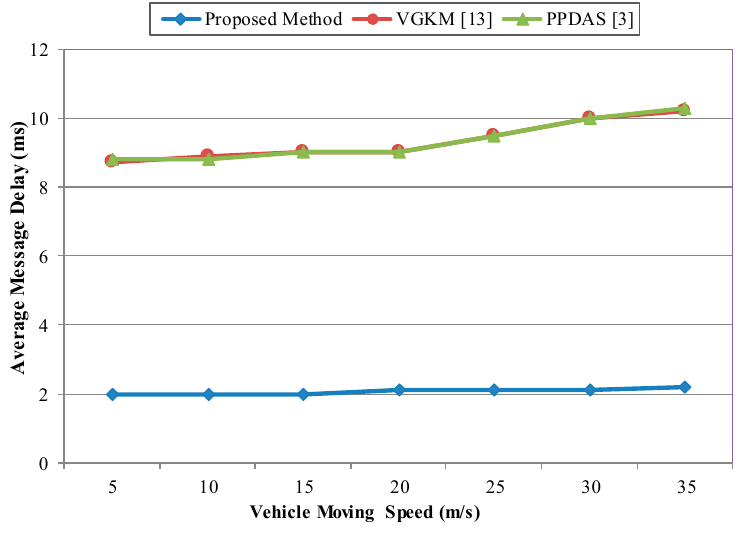
Figure 20. Average message delay vs. vehicle speed.